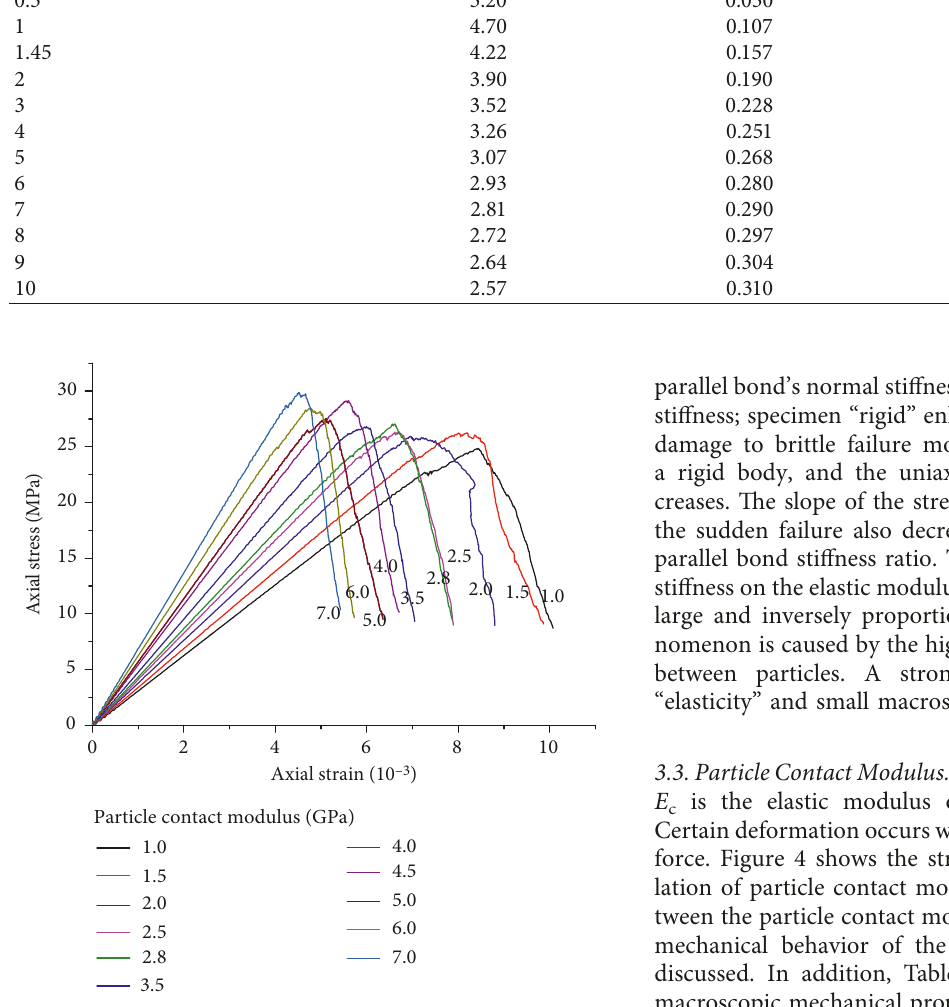
Figure 4: Stress-strain relation for different particle contact